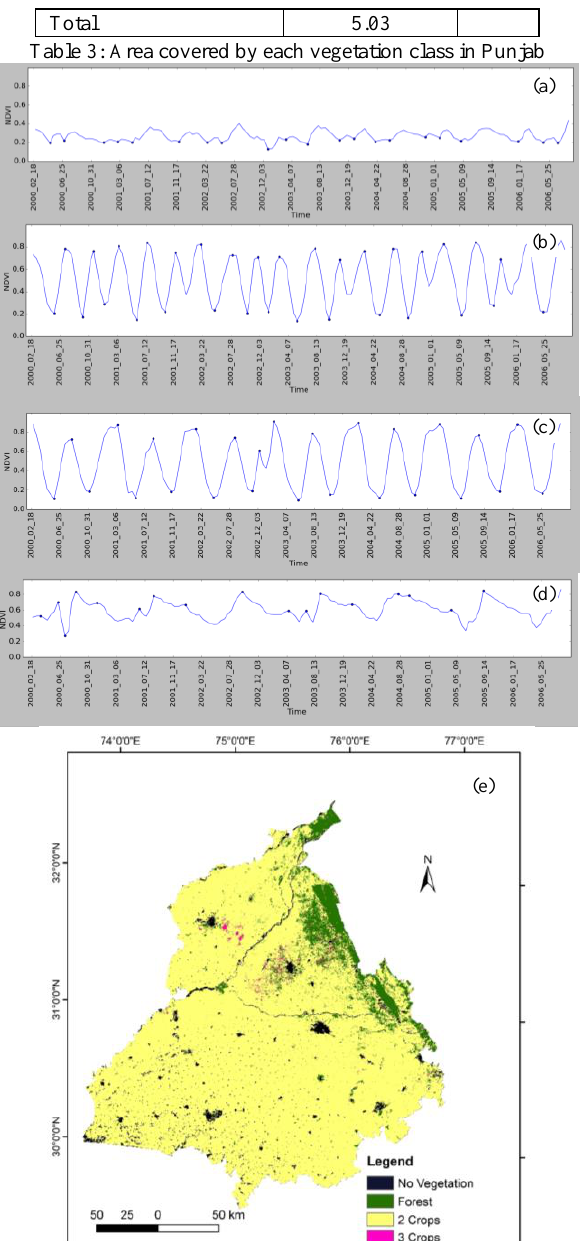
Figure 4: NDVI Time Series Plots in Punjab (a) No Vegetation (31.33 o N, 75.56 o E); (b) Three crops (31.59 o N, 74.99 o E); (c) Two crops (31.02 o N, 75.06 o E); (d) Forest (31.81 o N, 75.90 o E); (e) Cropping cycles map for